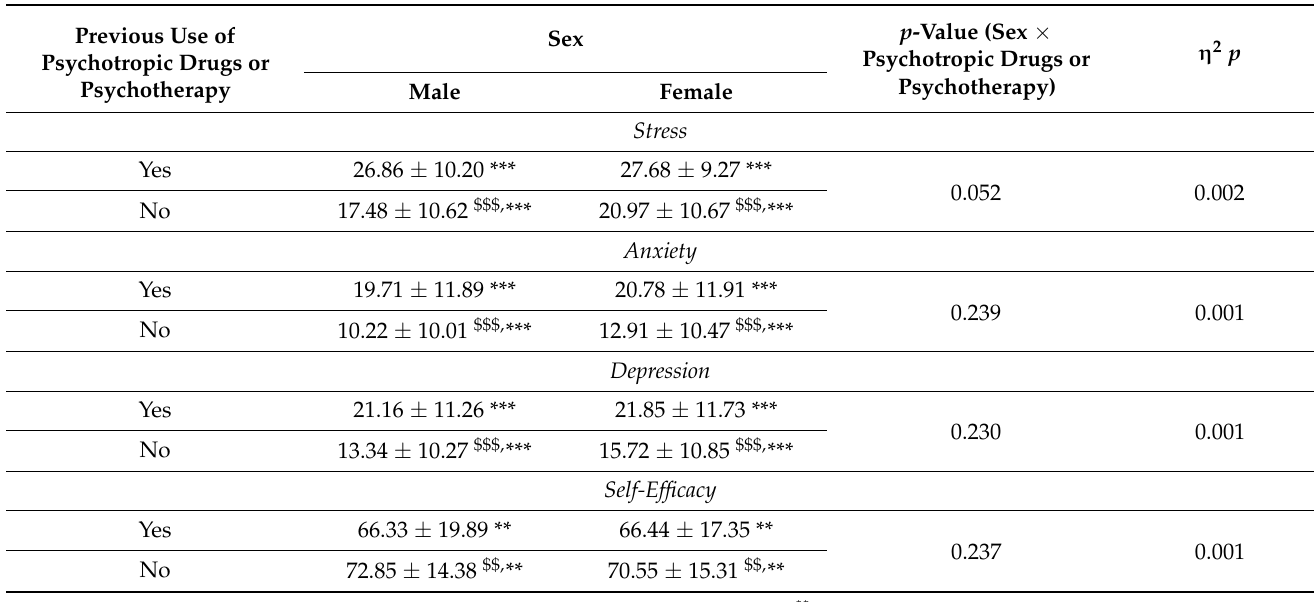
Table 3. Level of stress, anxiety, depression, and self-efficacy according to sex and previous use of psychotropic drugs or psychotherapy.